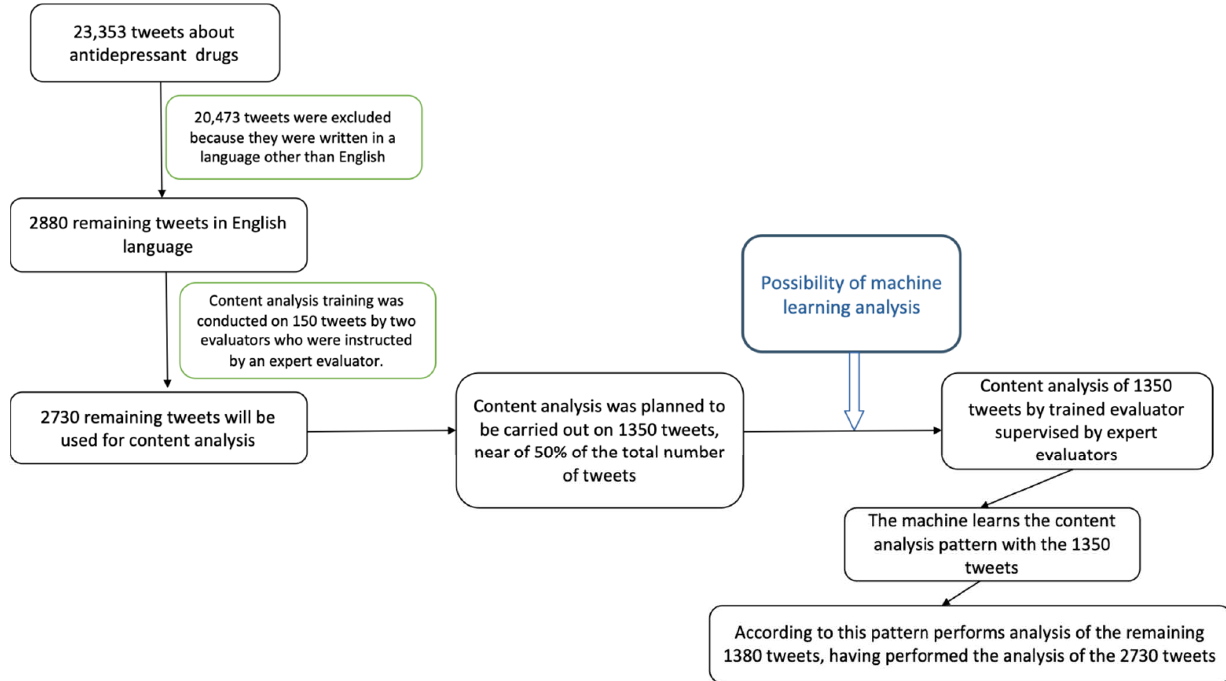
Figure 1. Flowchart of data management.